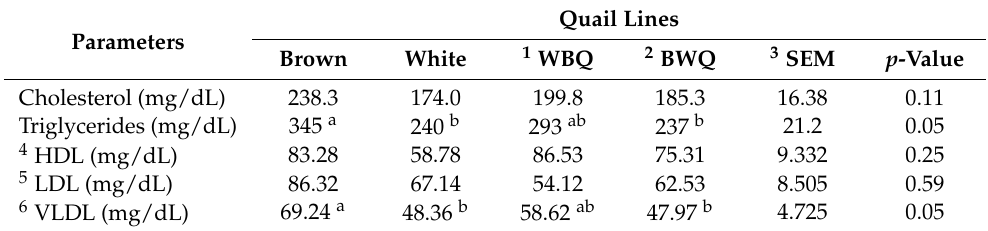
Table 5. Effect of crossing white and brown quail lines on blood lipid profile.